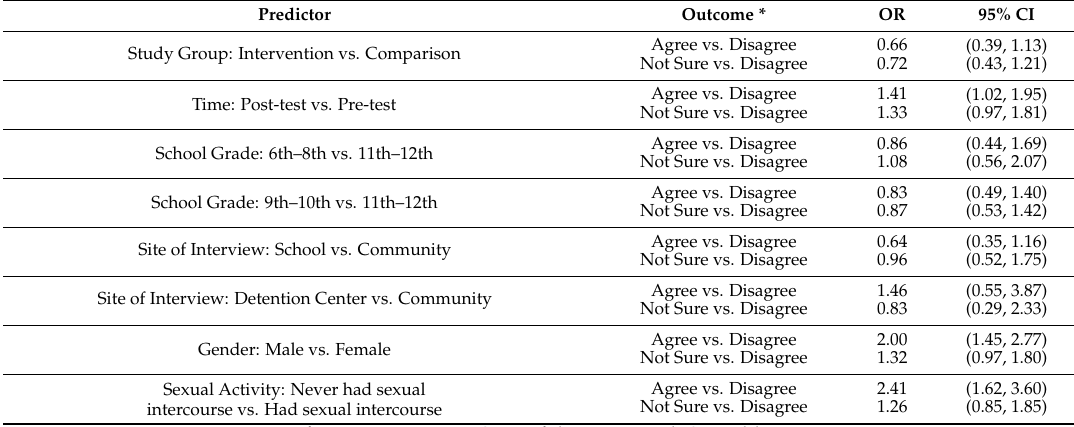
Table 4. Multivariable multinomial logistic regression to predict behavioral intention to abstain. Predictor Outcome * OR 95%